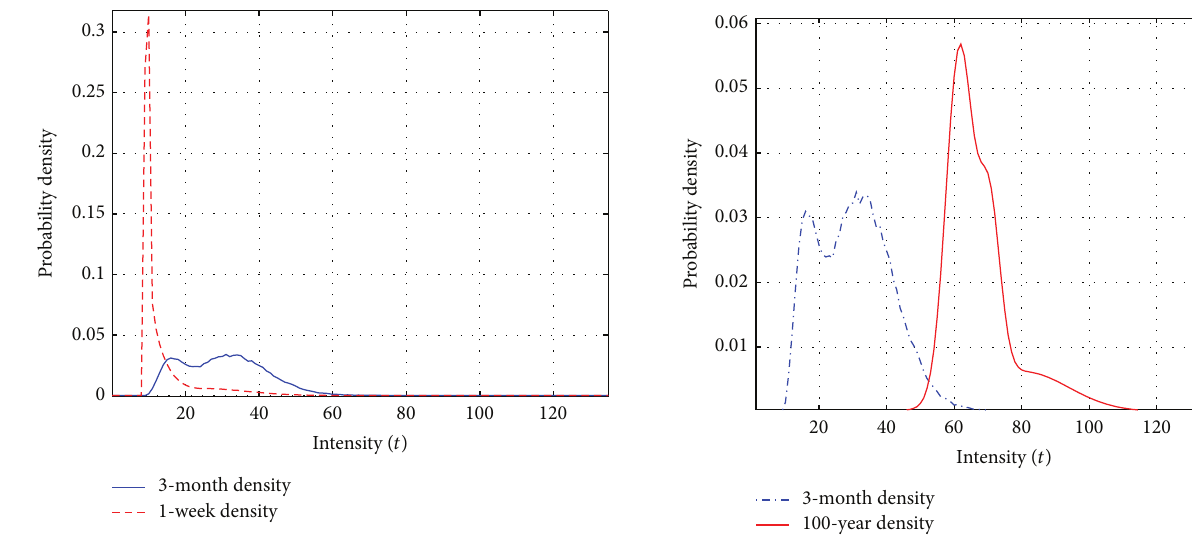
Figure 18: Probability density in 1 week.